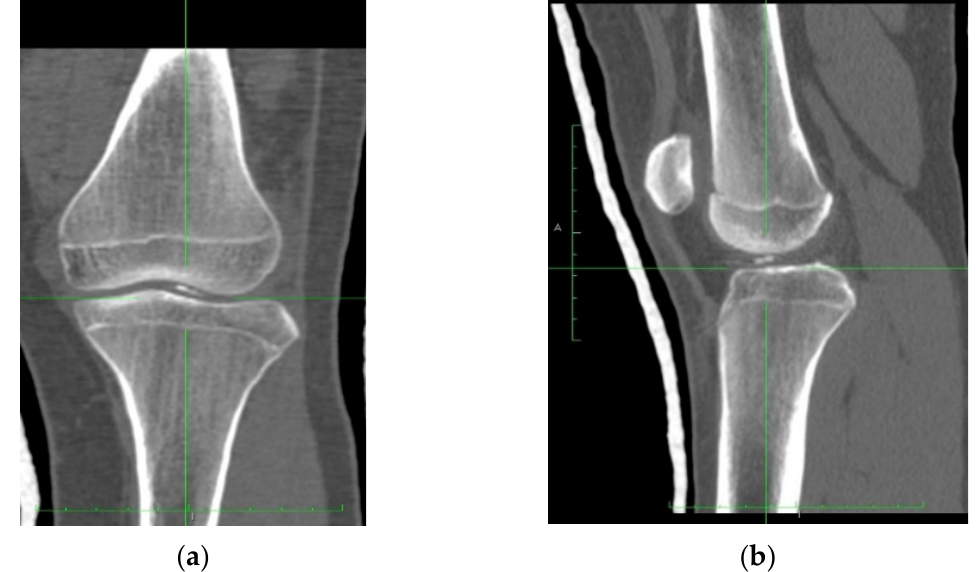
Figure 4. CT scans of the injured knee clearly showing the fractured fragment; ( a ) AP view and ( b ) L view.